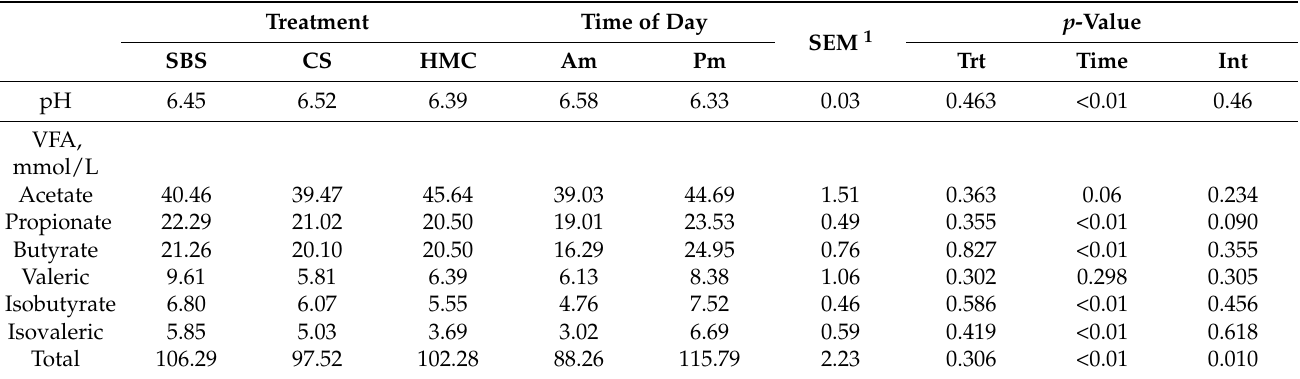
Table 6. Rumen fermentation parameters of grazing dairy cows supplemented with PMR composited by sugar beet silage, corn silage, or